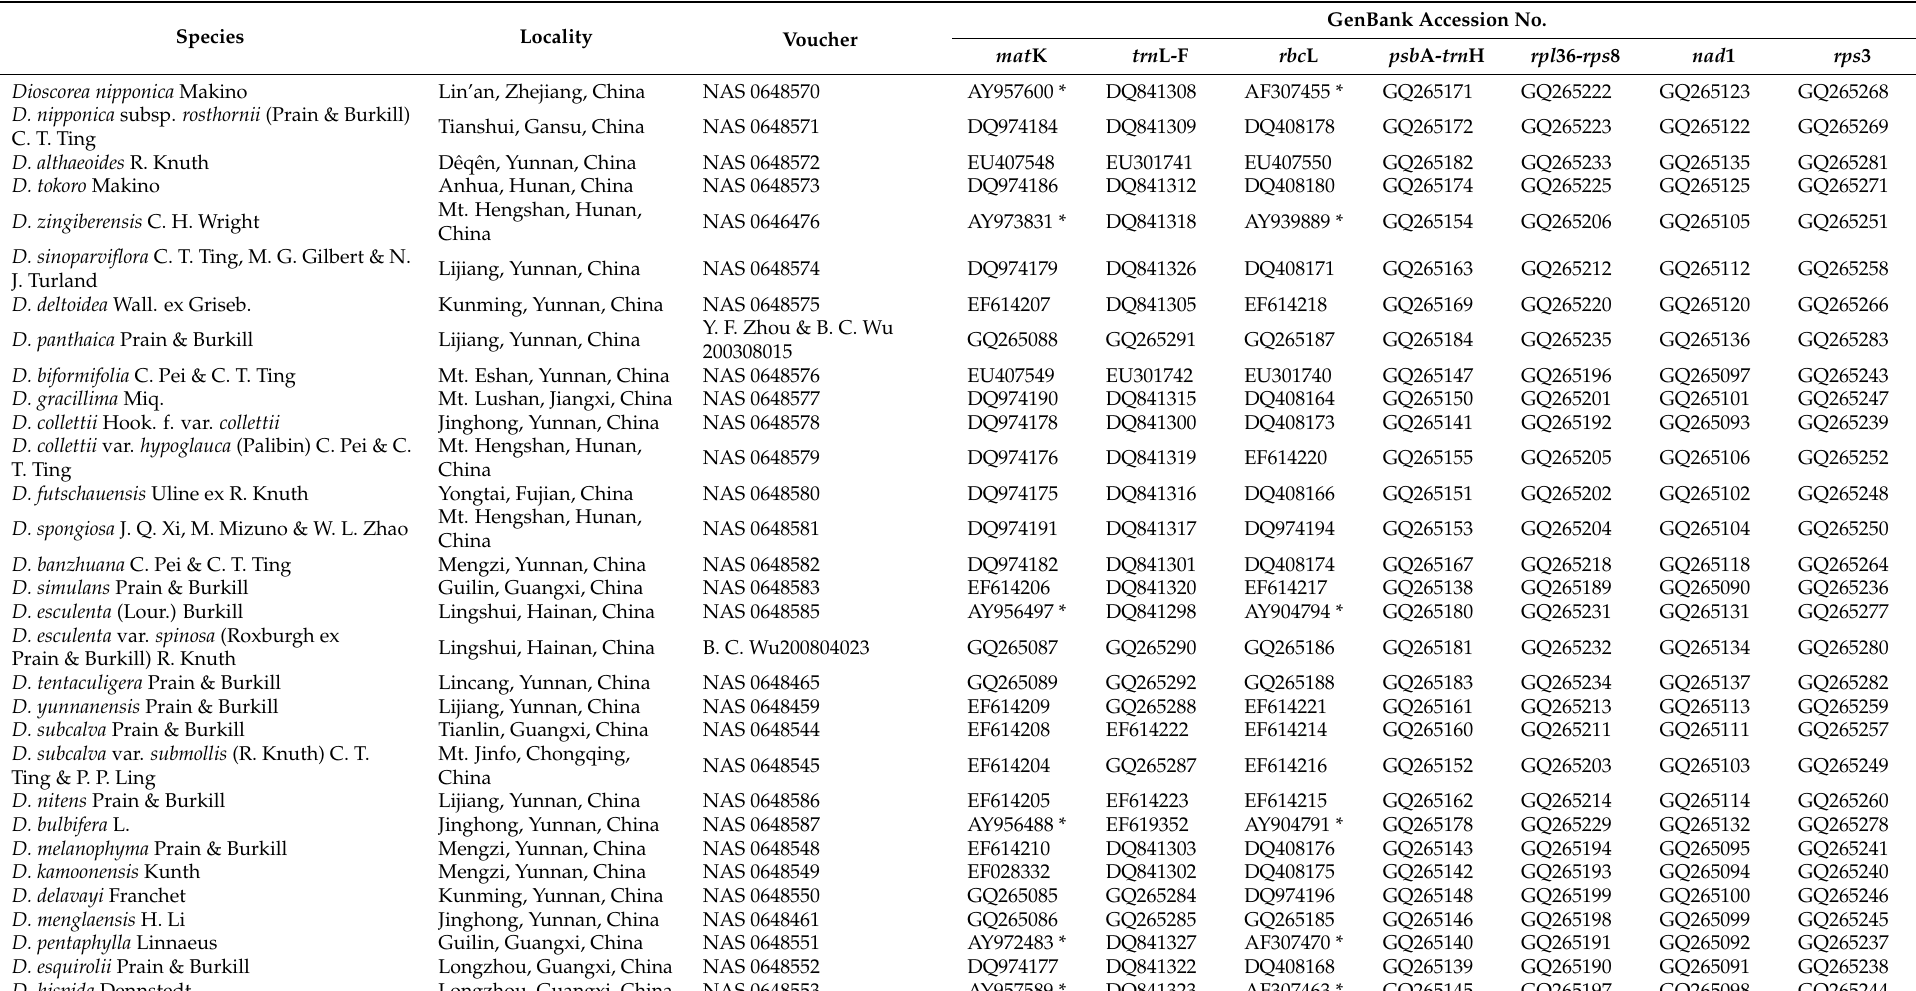
Table 1. Taxa used in this study with locality, voucher information and GenBank accession